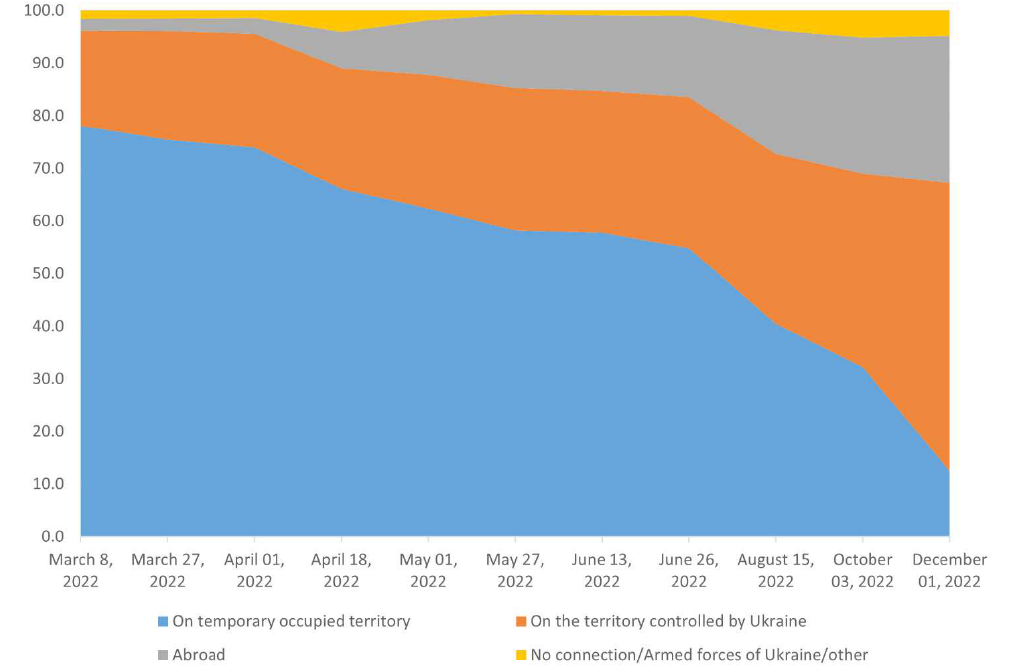
Figure 1. Relocation dynamics of Kherson State University students (%), 2022